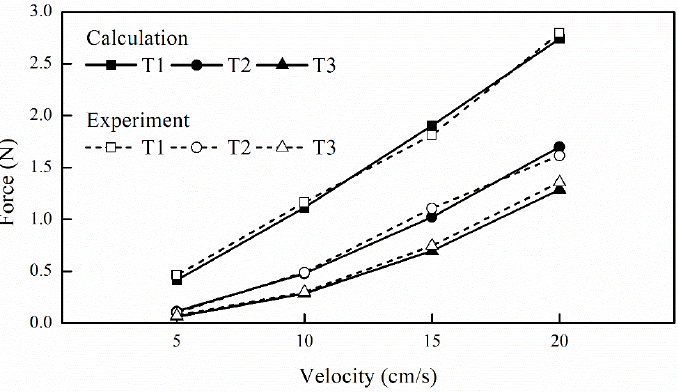
Figure 7. Tension force on the mooring lines from the numerical simulation and physical model test.